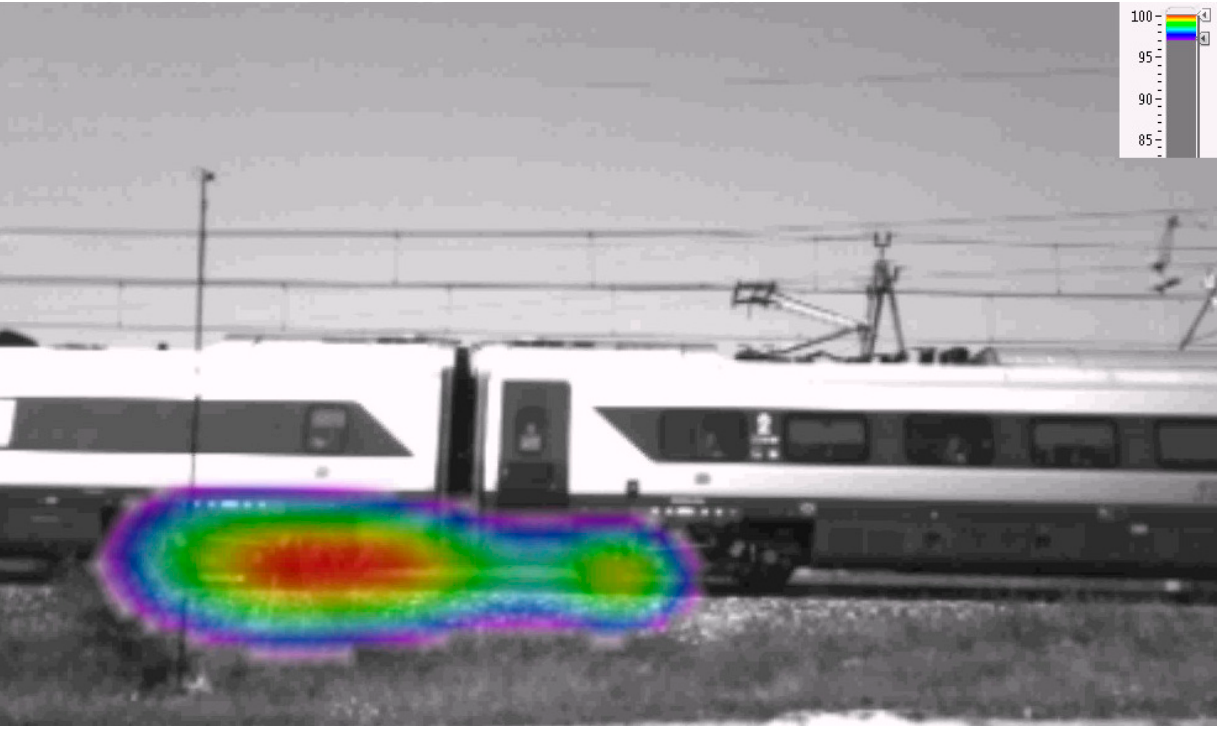
Figure 14. Sound level distribution within a frequency range of 1000–2000 Hz—curve .